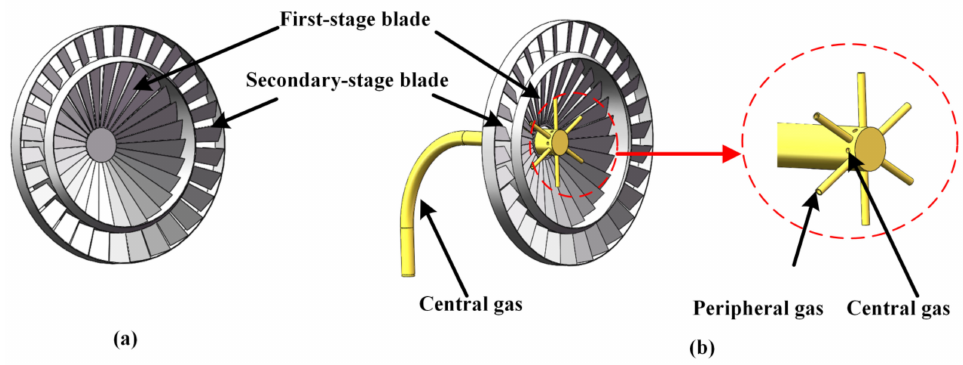
Figure 5. Three-dimensional structure of ( a ) D65-30 and ( b )